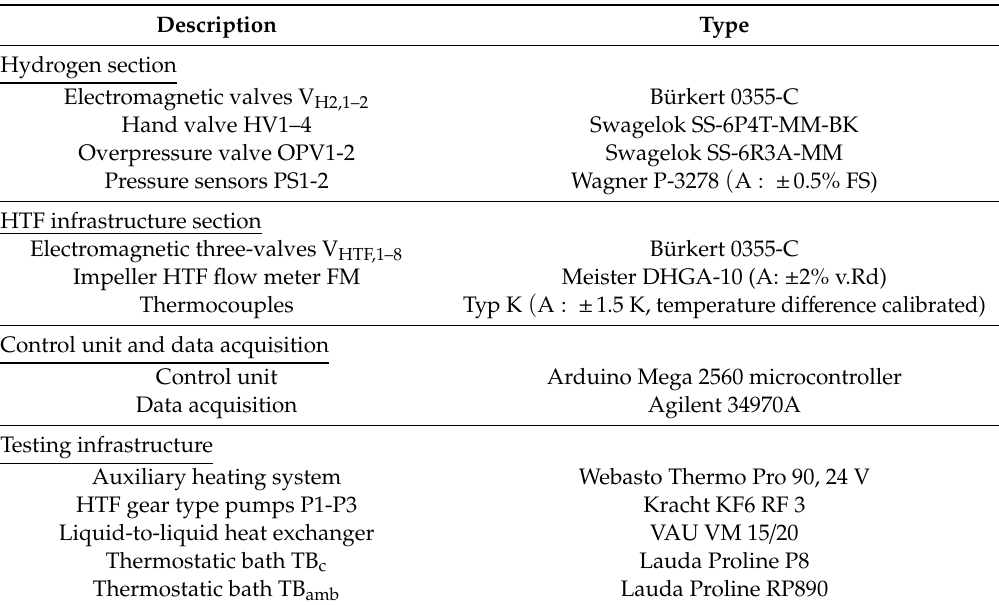
Table A1. Equipment of the MHCS and the testing